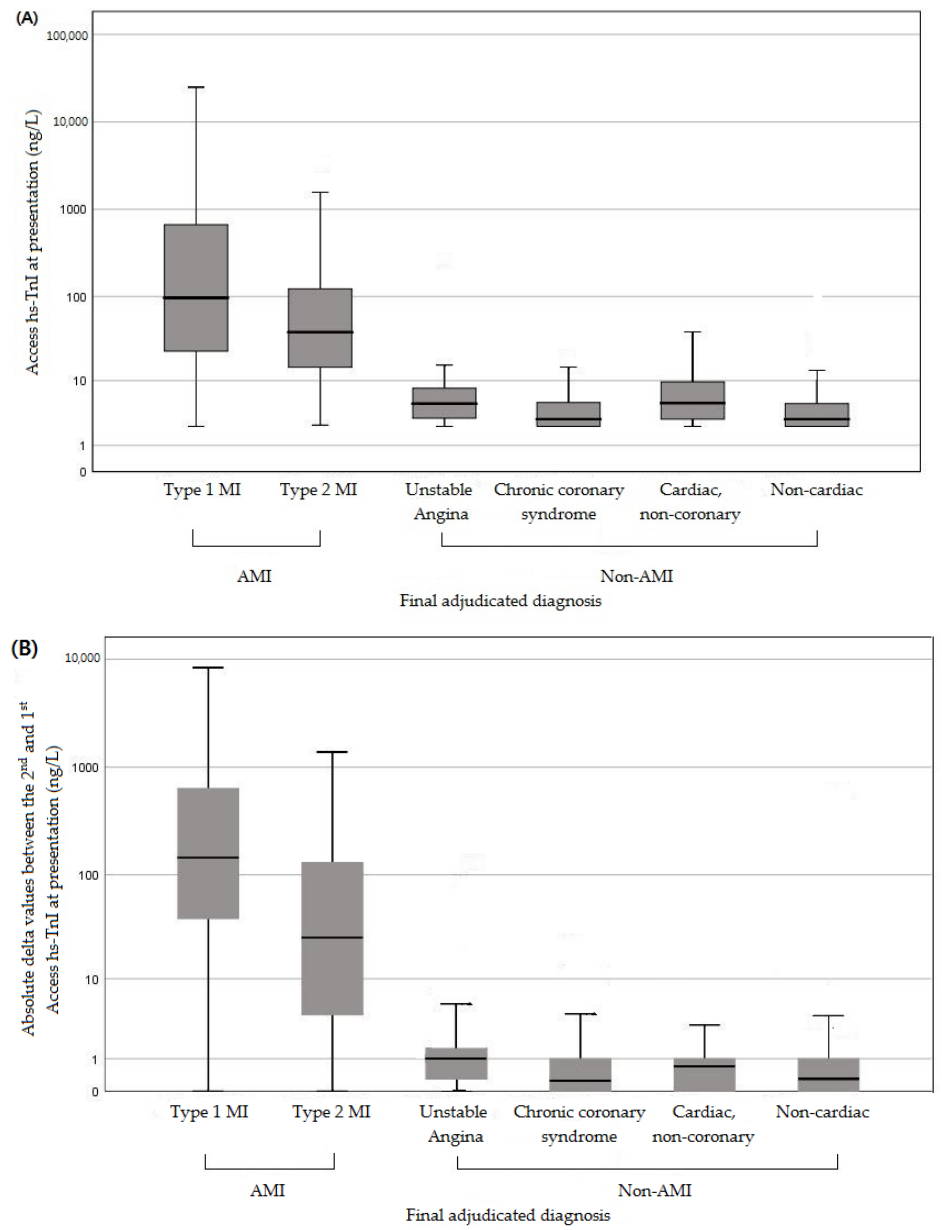
Figure 2. Boxplots of baseline at presentation ( A ) and absolute delta values ( B ) for the second and the first measurements with Access hs-TnI levels according to the final adjudicated diagnosis. The boxes represent medians and IQRs, and the whiskers represent the smallest and the largest non- outliers.